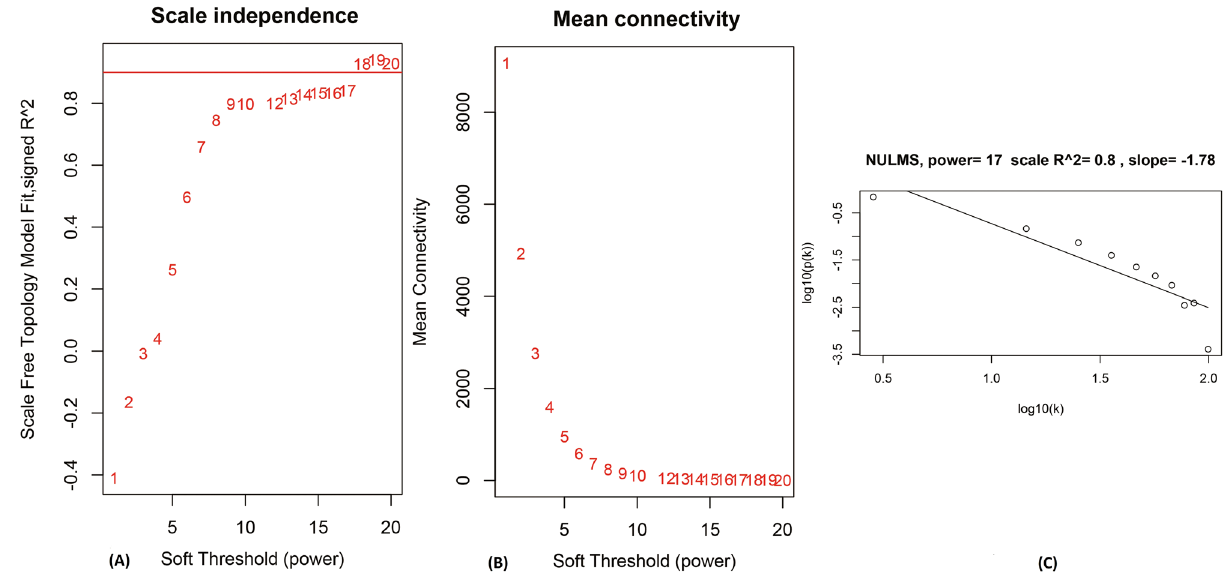
Figure 1. Analysis of network topology for several soft-thresholding powers in WGCNA. ( a ) Scale-free fit index for different powers (β). ( b ) Mean connectivity analysis for various soft-thresholding powers (β). ( c ) Linear model fitting of R2 index showed quality of relationship between connectivity (k) and